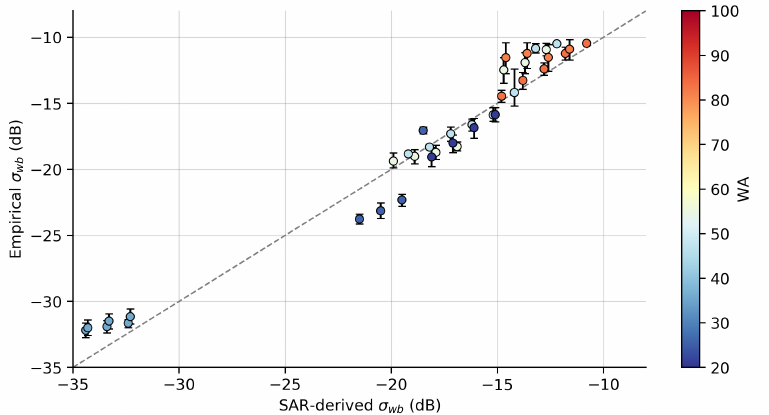
Figure 6. Comparison between σ wb estimated using Equation (5) (Empirical σ wb ) versus σ wb estimated from SAR images (SAR-derived σ wb ) using the BPM model. The observations were grouped into 1 dB bins, where the circles with vertical bars are mean values and percentiles of 5% and 95%. Colors represent the wave age of observations (see Table